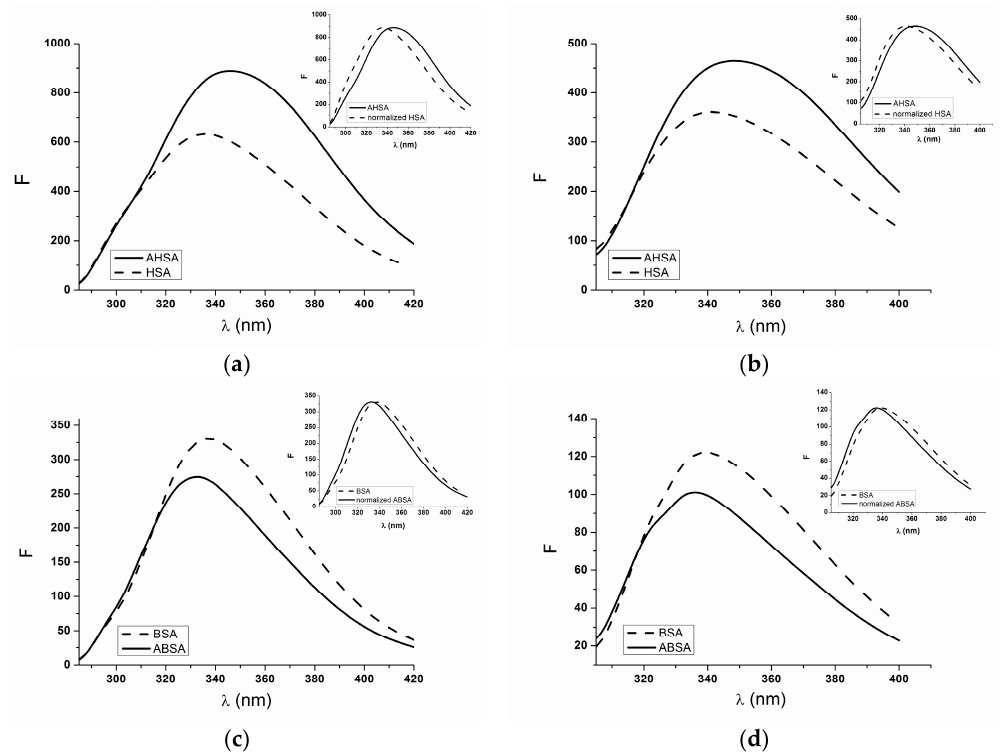
Figure 2. Fluorescence emission spectra of non-modified (HSA, BSA) and aged (AHSA, ABSA) human and bovine serum albumin excited at 275 nm ( a , c ) and 295 nm ( b , d ); in the insert: the spectra normalized to their respective maxima around 340 nm.